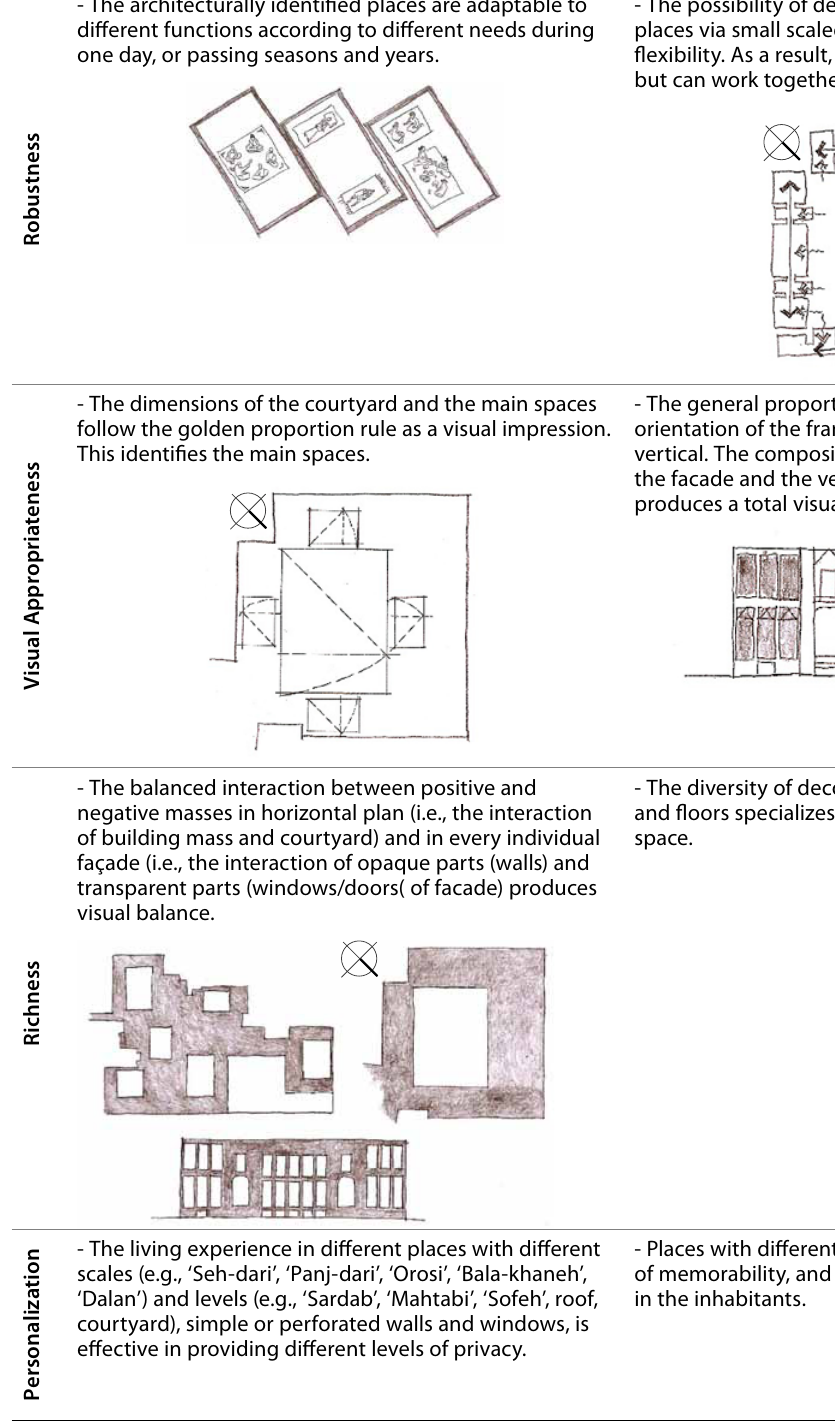
one day, or passing seasons and years.